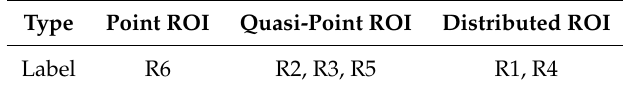
Table 2. Categories of ROIs in Figure 13c.